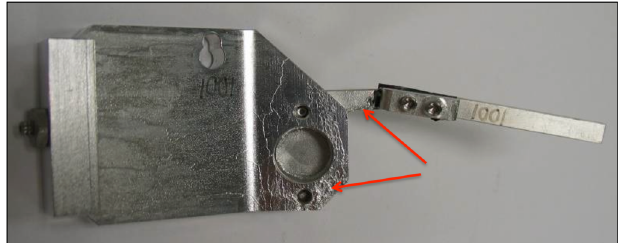
FIG. 4. Photograph of the 3rd generation foil mount assembly after it was removed from the injection chamber. The red arrows indicate the damage areas on the lower right corner of the bracket leg and the lower portion of the arm (figure reproduced from Ref.